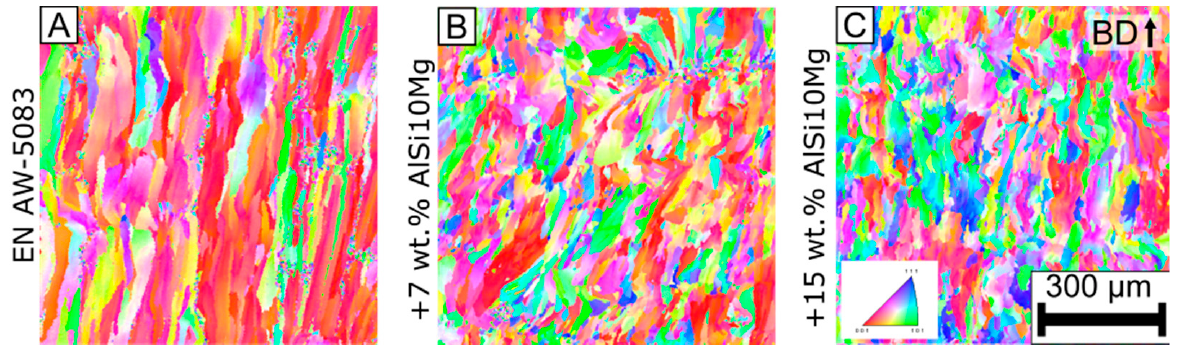
Figure 7. Electron back scattering diffraction (EBSD) for the ( A ) base alloy EN AW ‐ 5083, ( B ) MOD1 +7 wt.% AlSi10Mg, and ( C ) MOD2 +15 wt.% AlSi10Mg (Table 3). The process parameters for all specimens were p = 250 W, v = 1000 mm/s, and d f = 100 μ m (Table 2).